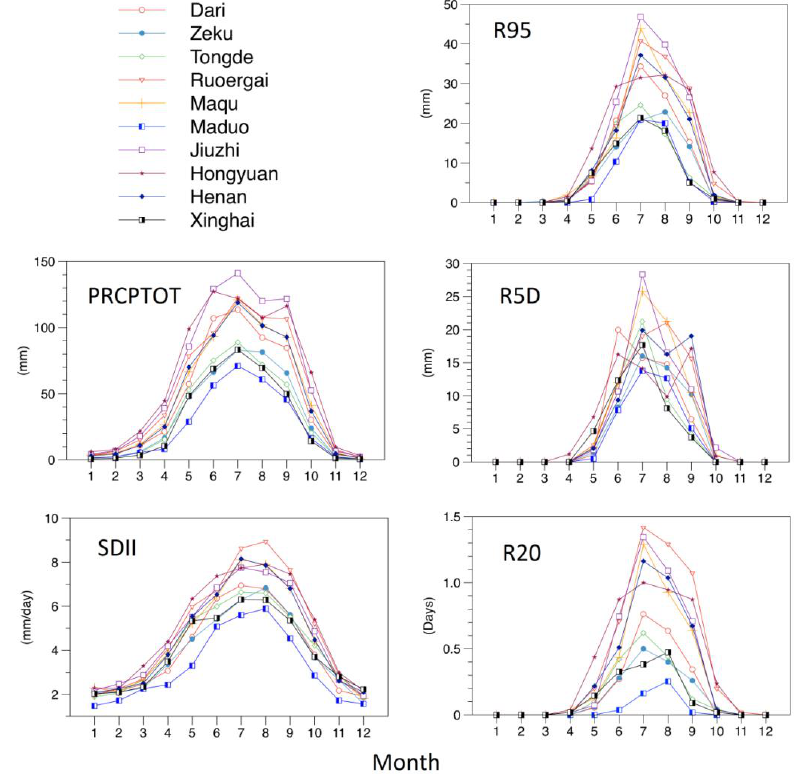
Figure 2. Long-term seasonal average of extreme precipitation indices.